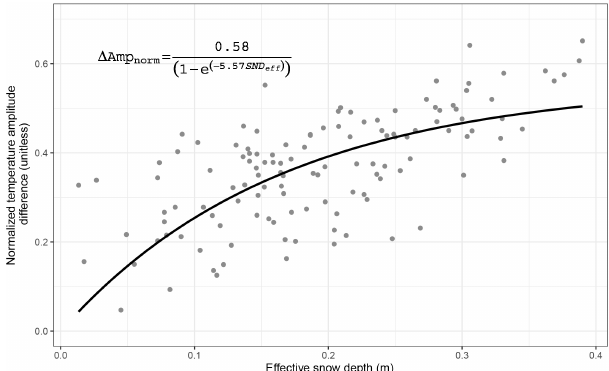
Figure 10. Correlation between effective snow depth and normal- ized temperature amplitude difference between air and ground sur- face. The mathematical function of fit line follows the correlation showed in Slater et al.